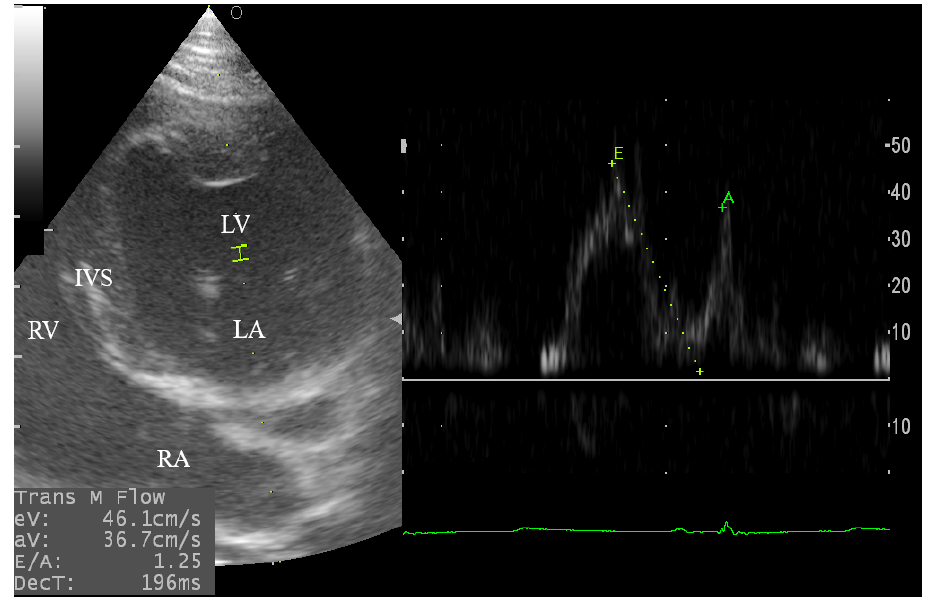
Figure 4. Pulsed wave Doppler echocardiography for evaluation of the mitral inflow in male goats through the left apical 4-chamber view. The sample volume was adjusted at 2.0 mm. The mitral inflow spectral velocity appears as early diastolic wave (E), and late diastolic wave (A) that resemble the atrial contraction. LV, left ventricle; DecT, deceleration time; LA, left atrium; RA, right atrium; RV, right ventricle; IVS, interventricular septum.